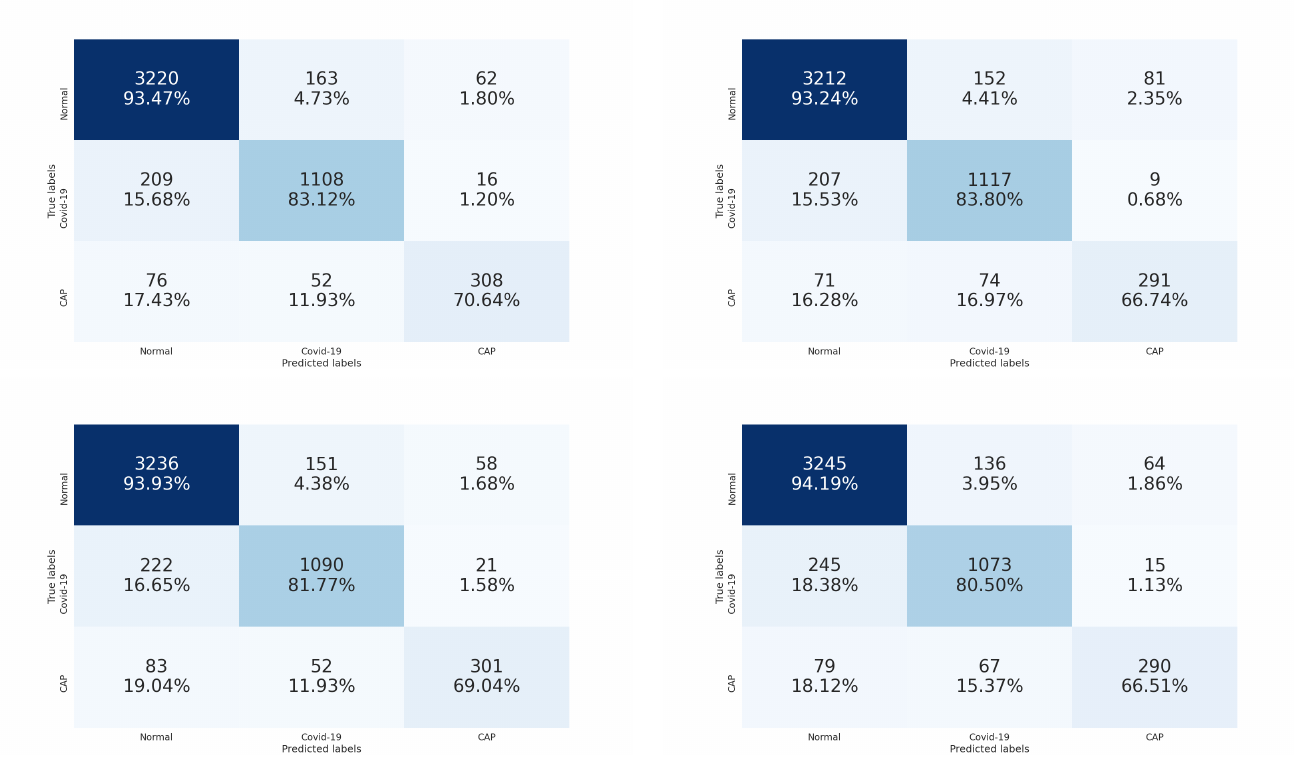
Figure 9. Confusion matrices of the three classes of COVID-19 testing data using ResneXt-50, Densenet-161, Inception-v3, and Wide-Resnet-50, respectively. The vertical axis is for the true classes, and the horizontal axis is for the predicted